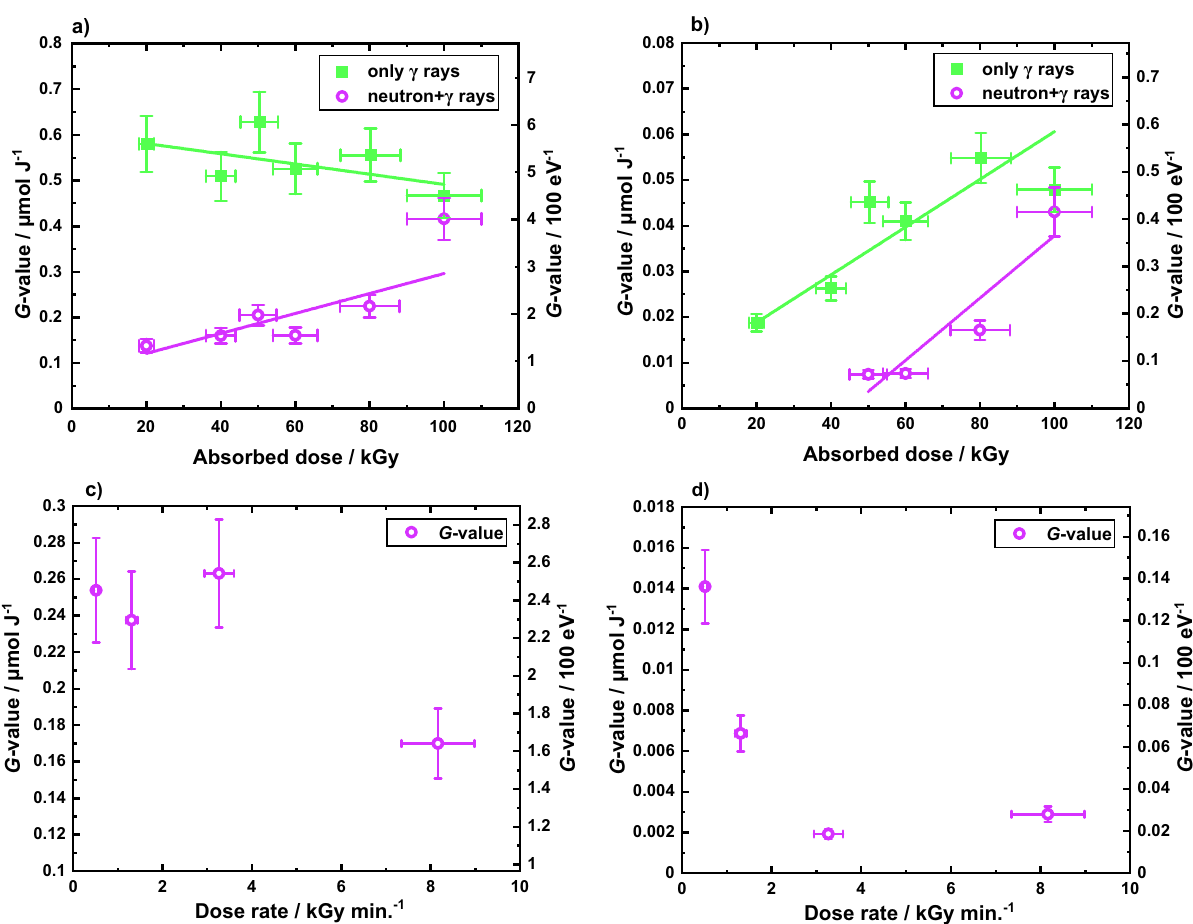
Fig. 1 Radiation-chemical yields ( G -values) of acetol and solketal from neat glycerol. Given for the speci fi ed dose of either γ -ray (green squares) or neutron + γ -ray (magenta open circles) irradiations: ( a ) acetol and ( b ) solketal, as a function of absorbed dose, and ( c ) acetol and ( d ) solketal, as a function of dose rate. Samples in ( a ) and ( b ) were irradiated with dose rates ranging between 18 and 40 Gy min − 1 for γ rays and between 1600 and 6500 Gy min − 1 for the mixed fi eld, while samples in ( c ) and ( d ) were irradiated with 50 kGy of mixed- fi eld absorbed dose. The relationship between the two G quantities is 1 molecule (100 eV − 1 ) ≡ 0.1036 µ mol J − 1 . (Data and linear analysis are available in Supplementary Tables 2, 3 and 4); x -axis error bars derive from absorbed dose uncertainties, y -axis error bars represent the combination of errors from the relative standard deviation% (RSD%) of analyte concentration curves and absorbed dose uncertainties for each